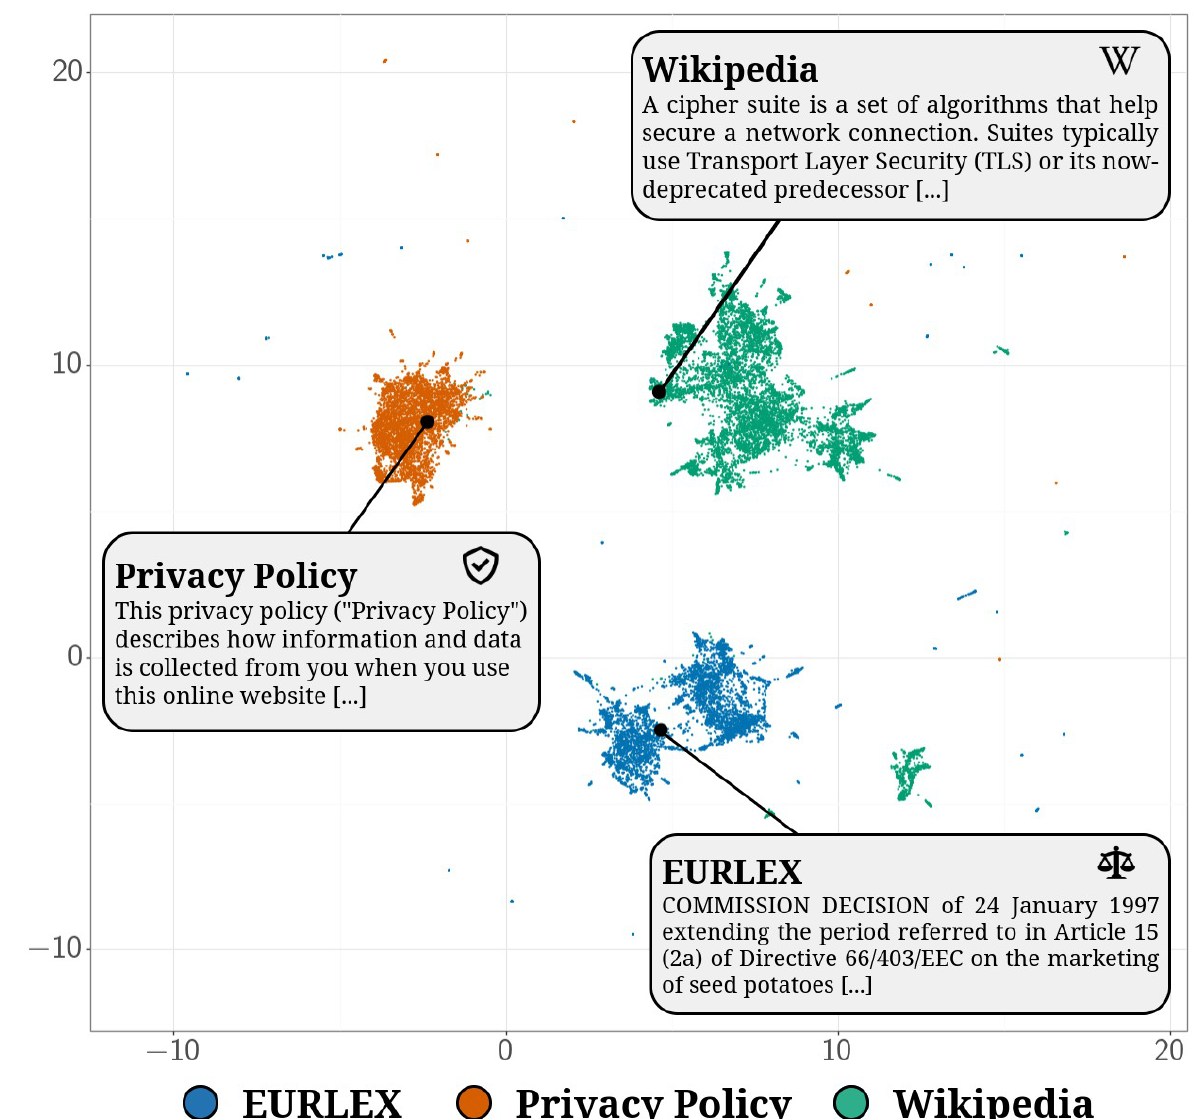
Figure 1. UMAP visualization of BERT embeddings from Wikipedia, European Legislation (EURLEX) and company privacy policy documents with a total of 2.5 M tokens per